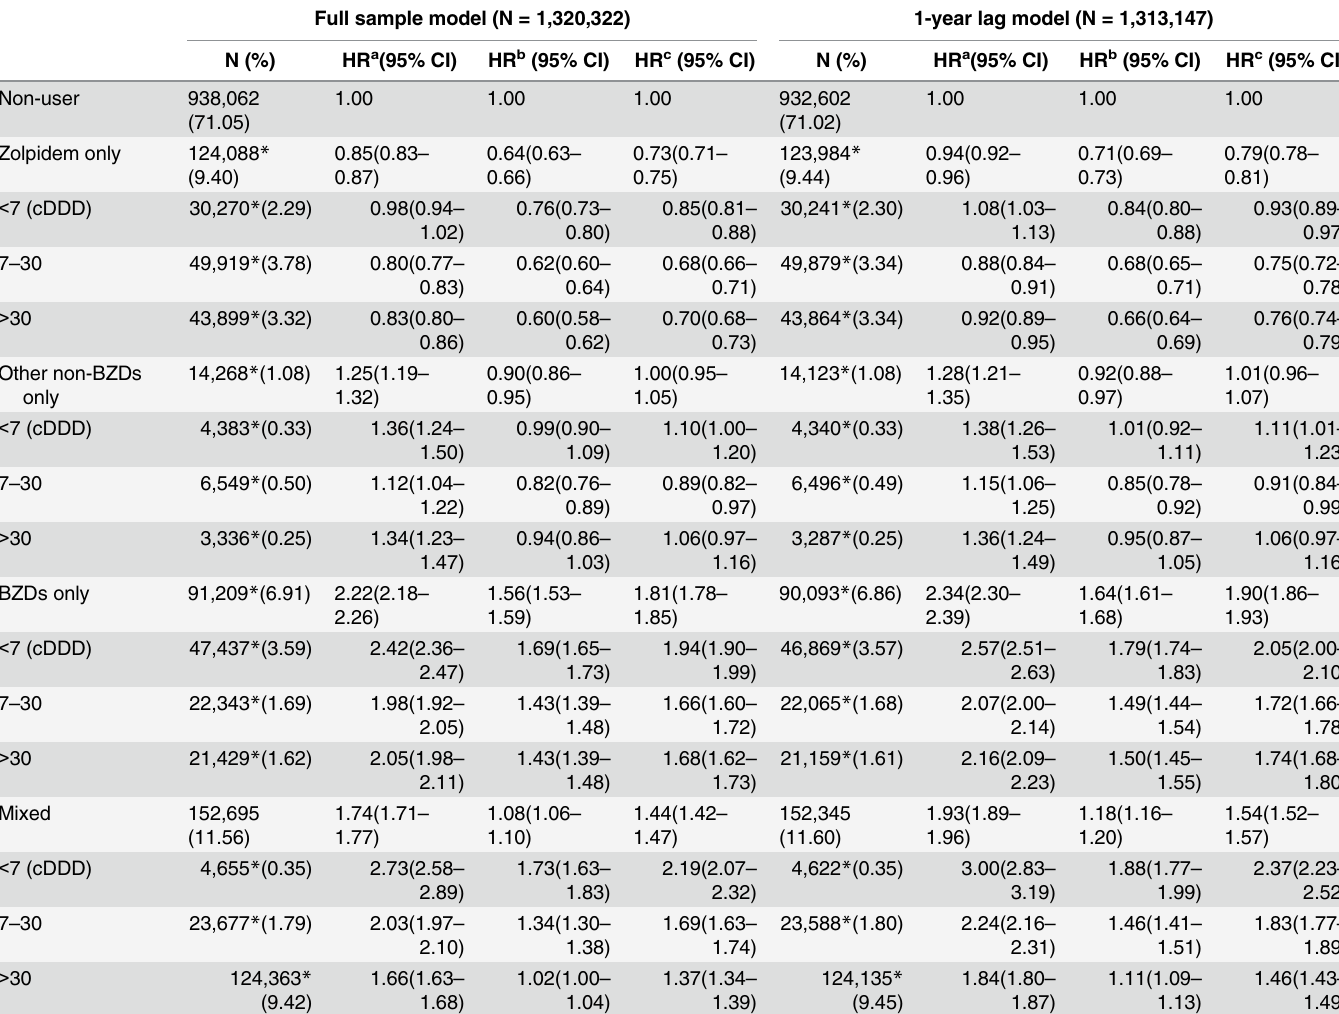
Table 3. Adjusted risk of mortality for the hypnotic